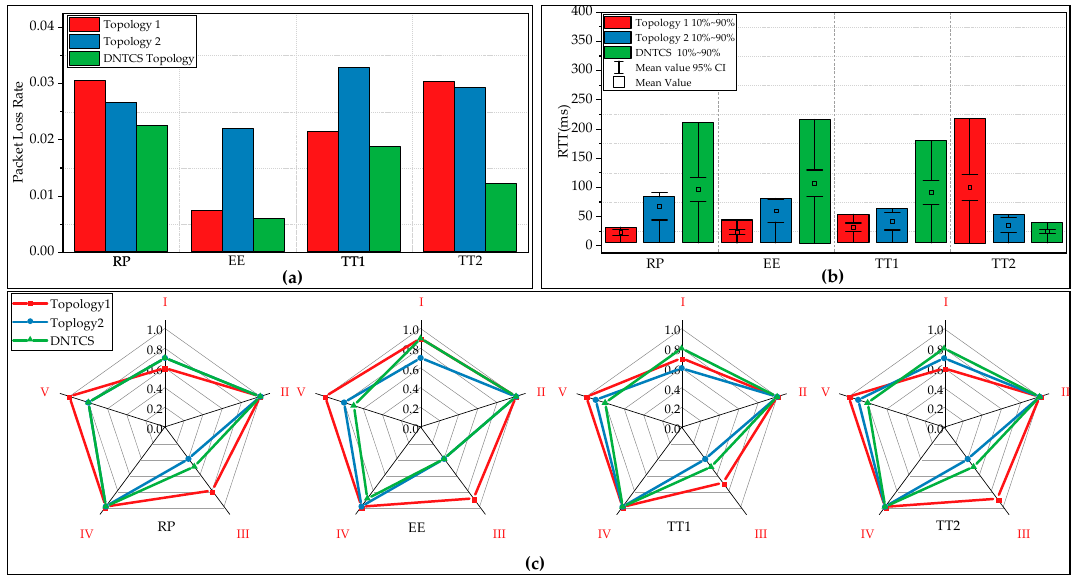
Figure 18. Results for Scenario 2 regarding the network performances of the mobile nodes. ( a ) Packet loss rate; ( b ) RTT; ( c ) normalized performance metrics.